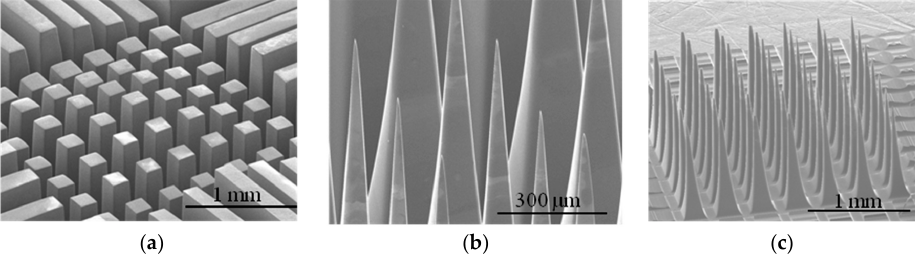
Figure 6. SEM images of electrodes frontside: ( a ) 3D pyramid-shaped electrode array with three different heights. The outer row of electrodes is for etching process uniformity; ( b ) polishing and sharpening the tips of electrodes by applying N 2 gas from the bottom of the solution; and ( c ) one 3D 7 × 7 MEA. The width of the electrodes was 200 µm at the base and about 2 µm at the tip with 100 µm spacing after etching step.